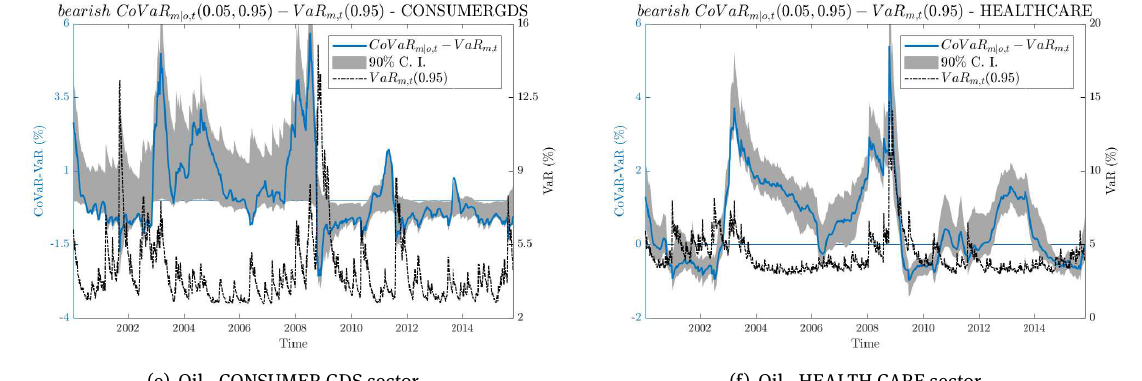
Figure 16b: CoVaR m | o , t (0.05, 0.95) for a certain sector given a bearish scenario for oil prices